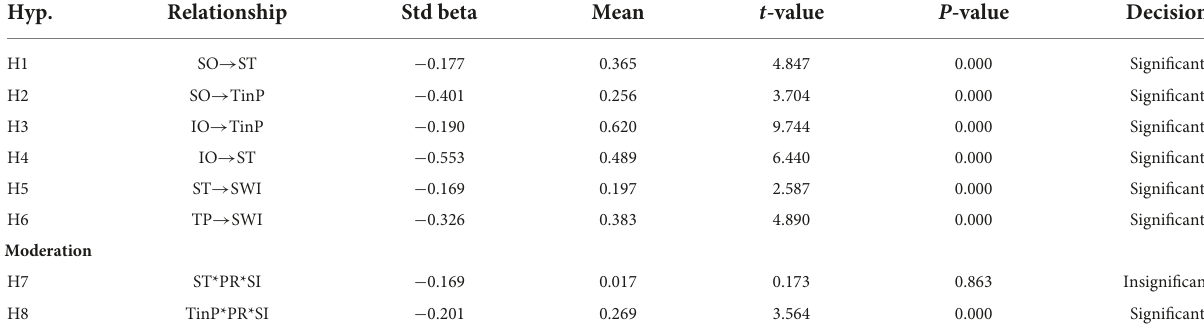
TABLE 6 Hypotheses and moderation results. Hyp.